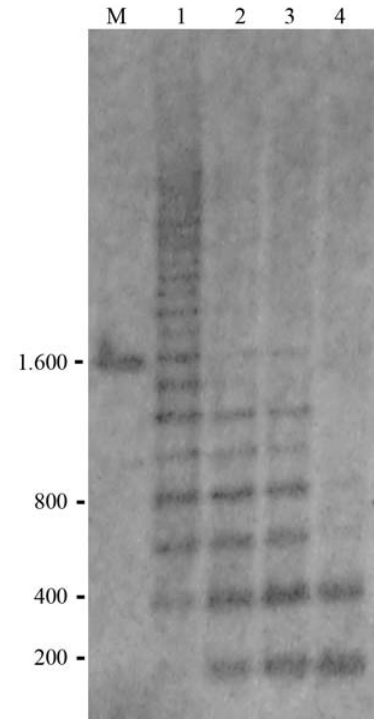
Figure 4 - Southern blot hybridization results of 5S rDNA sequences to genomic DNA of Isopisthus parvipinnis digested with Hind III endonuclease. 1, 2 and 3 are partially digested genomic DNA samples (10, 30 and 60 min digestion, respectively), and 4 is a totally digested DNA sample. M, molecular mass marker